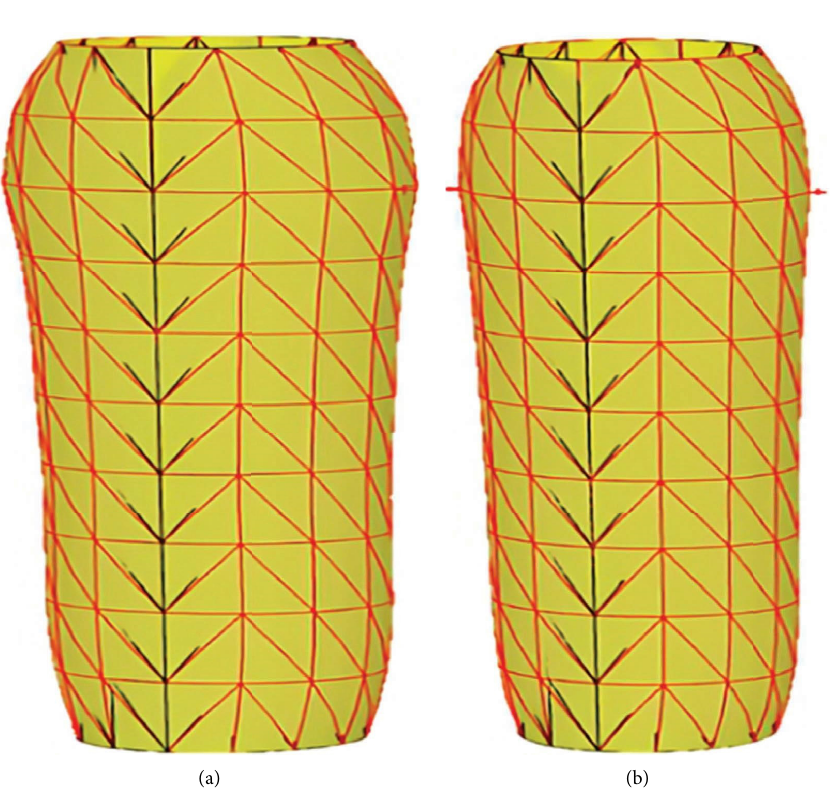
Figure 10: Efect of bulging: (a) SL-GESC and (b)